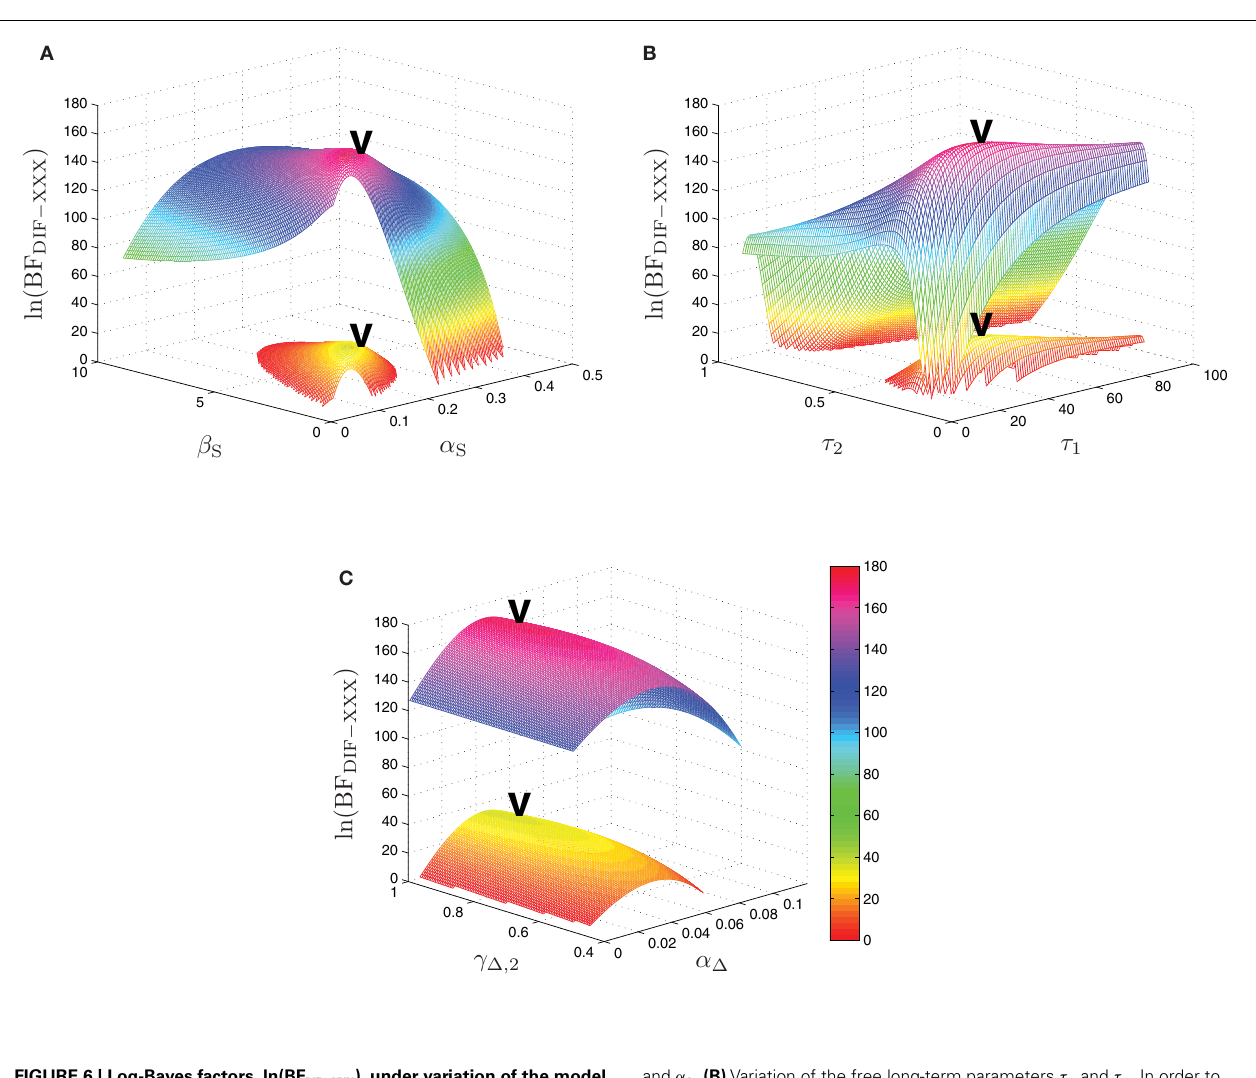
FIGURE 6 | Log-Bayes factors, ln(BF DIF − XXX ), under variation of the model parameters. The upper contour always shows ln(BF DIF − MAR ), the lower one ln(BF DIF − SQU ).The “V” marks the parameter combination with the maximum log-Bayes factor, cf. Table 3 . (A) Variation of the free short-term parameters β S